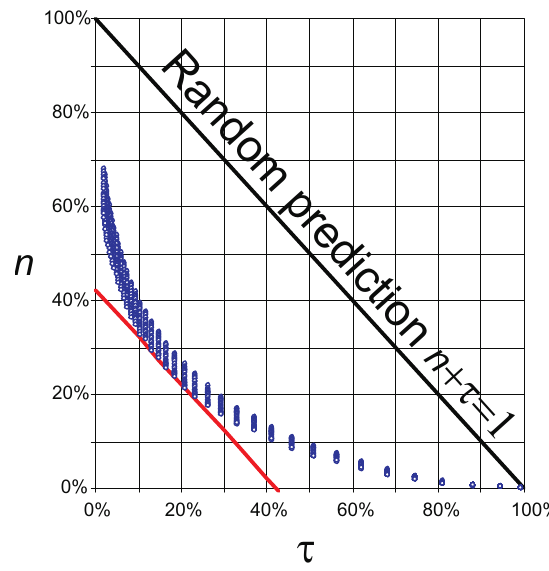
Fig. 9. R ∗ for next hour vs R ∗ for current hour computed from minute values at CLF: 2-D